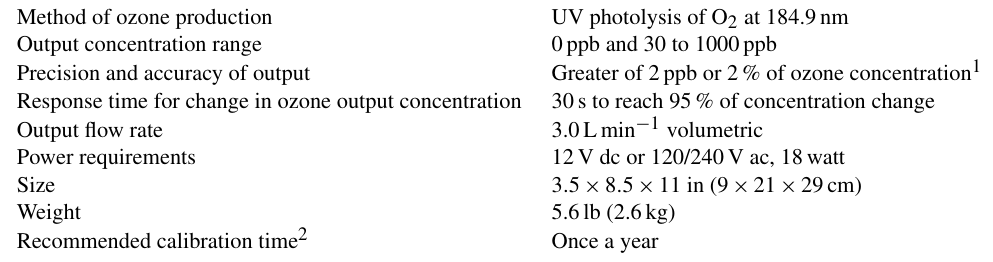
Table 2. Analytical and physical specifications for ozone calibration source.